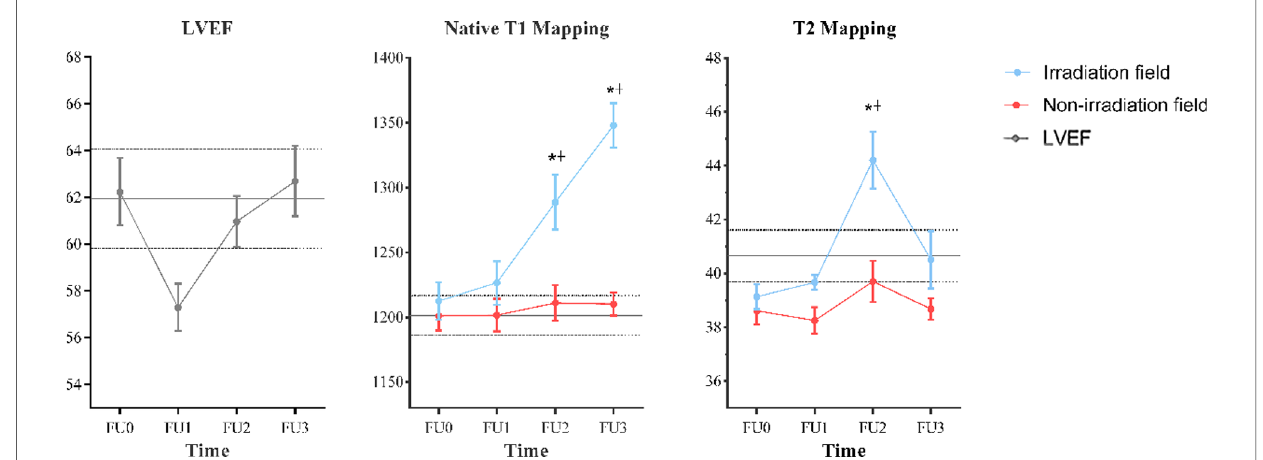
FIGURE 3 Temporal evolution ofCMR measurements. Data are represented as mean±SD. The parallel gray solid lines represent the mean values ofage/gender-matched controls and the interval of two parallel gray dotted lines represents their 95% CI. *Statistically signi fi cant differences compared with FU0: P <0.01. † Statistically signi fi cant differences compared with the values measured in the nonirradiation fi eld: P <0.05. CMR, cardiac magnetic resonance; FU0,